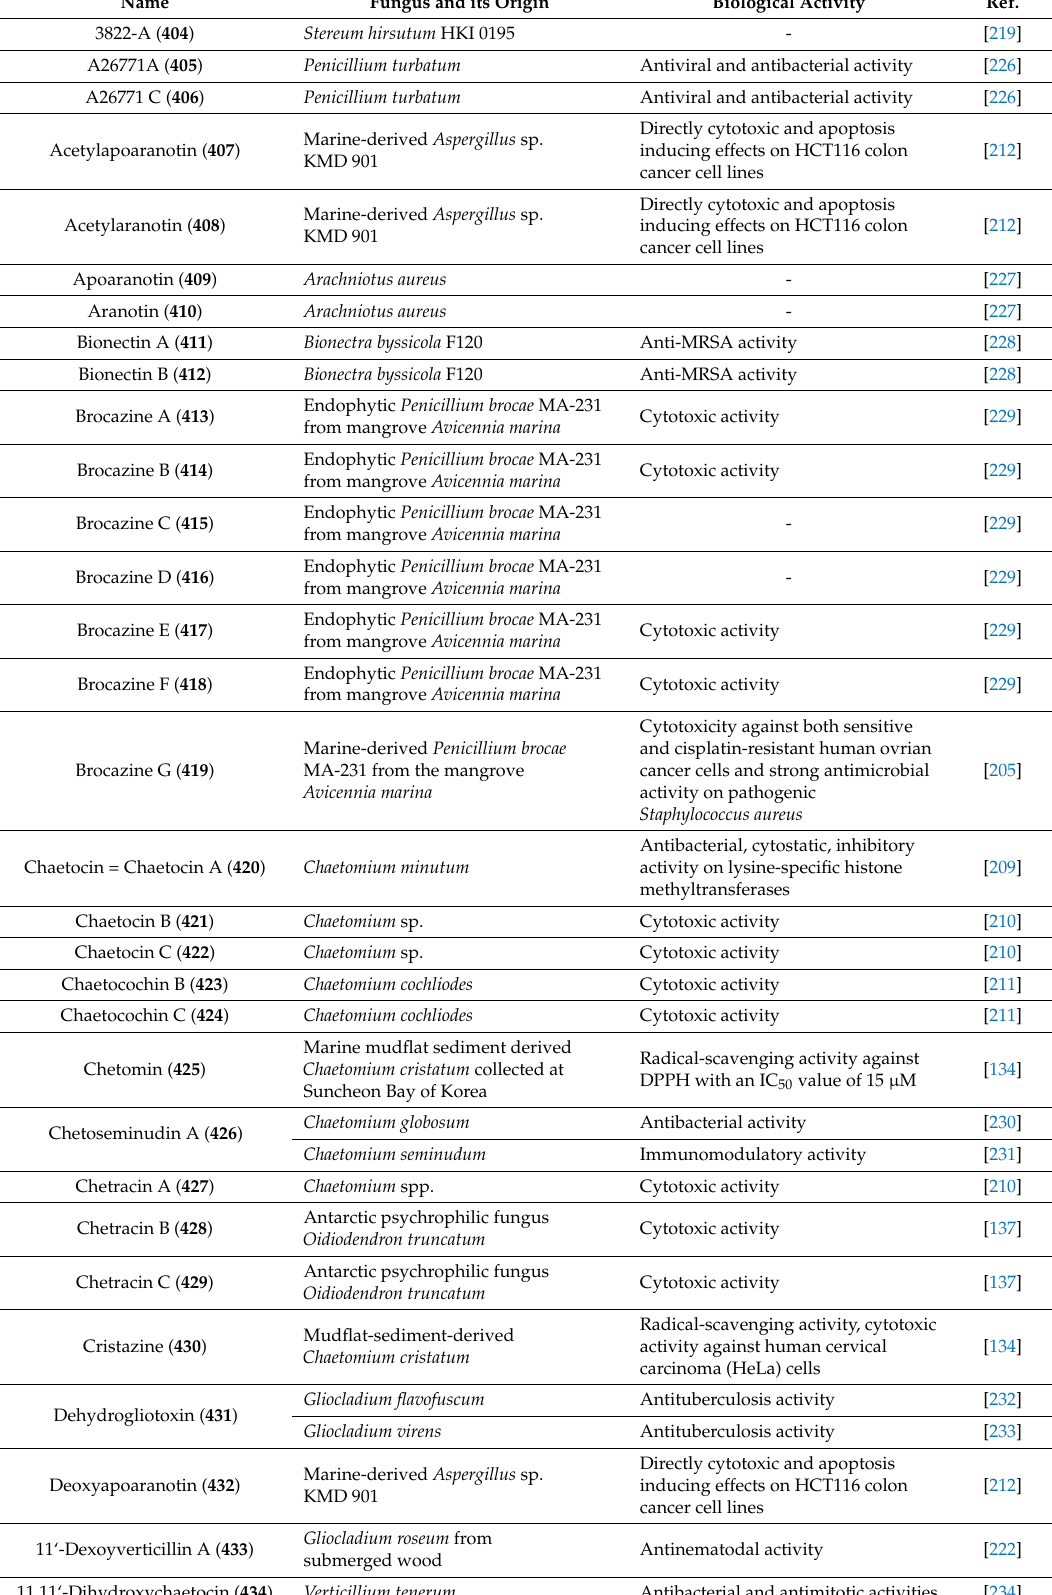
Table 6. Fungal 1,4-bridged epiplythiodioxopiperazine analogs and their biological